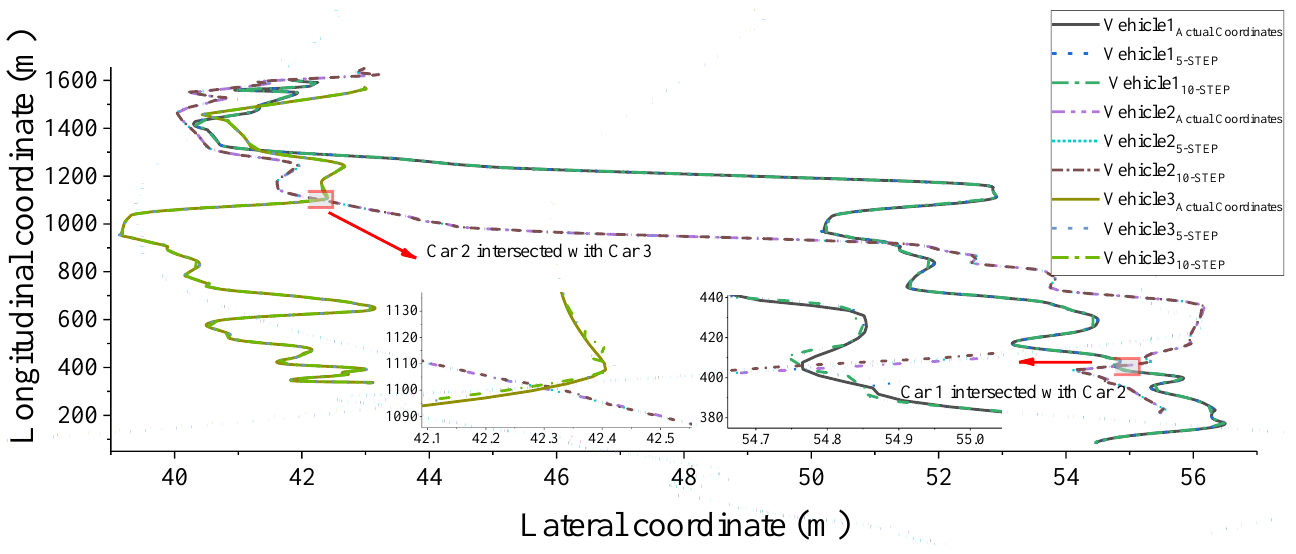
Figure 9. Multi-step prediction of multi-vehicle trajectory results.